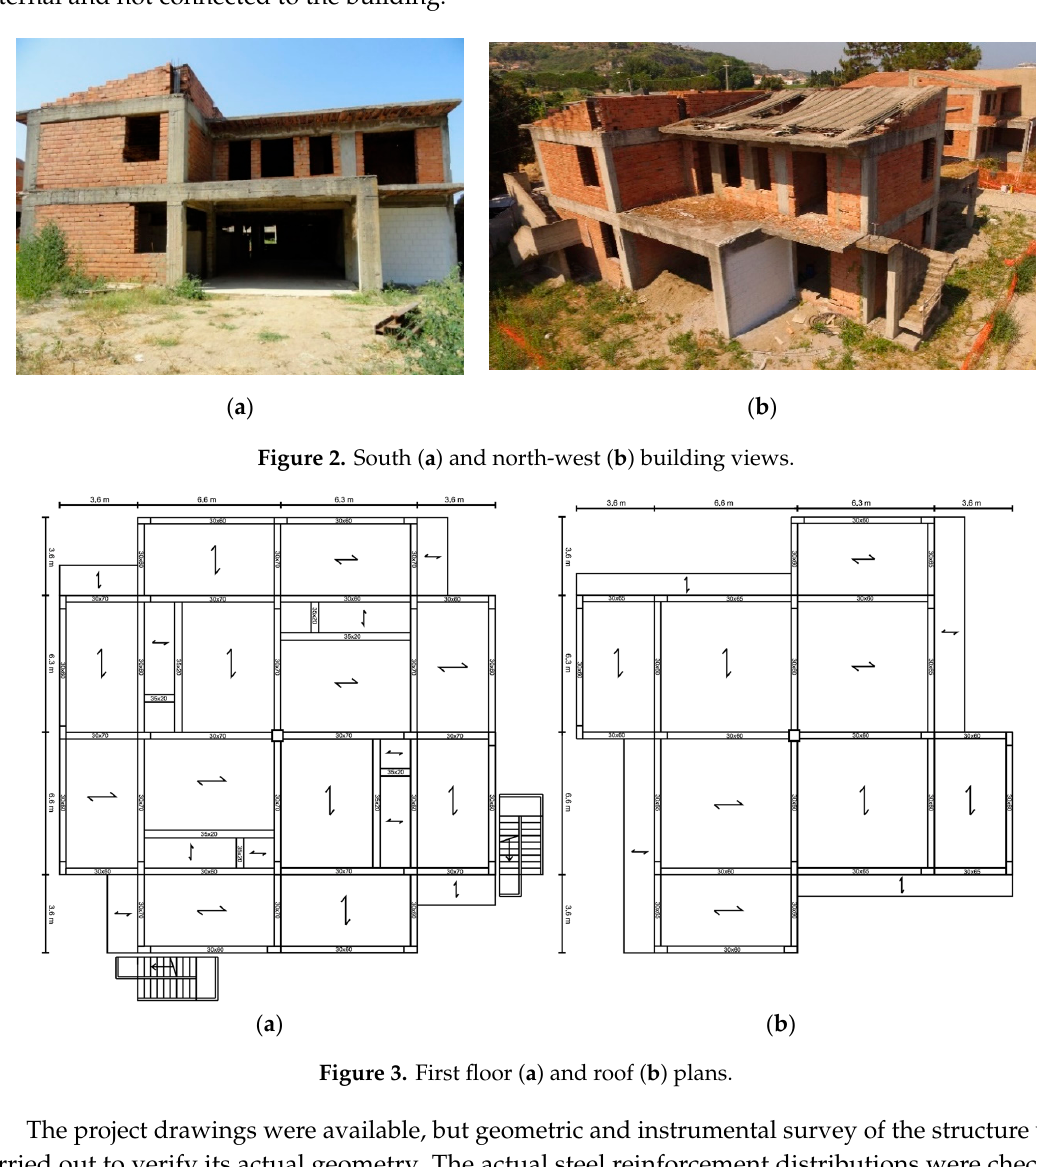
Figure 3. First floor ( a ) and roof ( b ) plans.